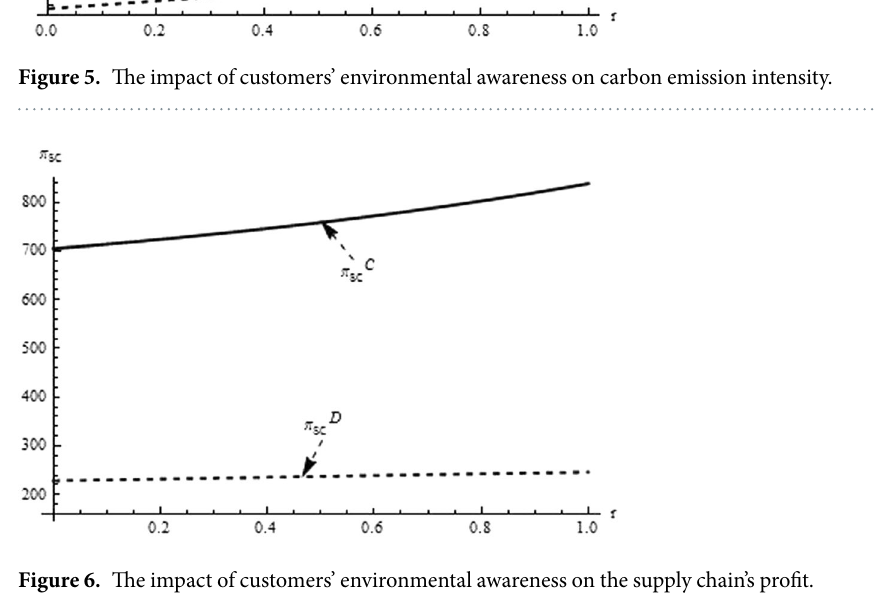
Figure 6. The impact of customers’ environmental awareness on the supply chain’s profit.